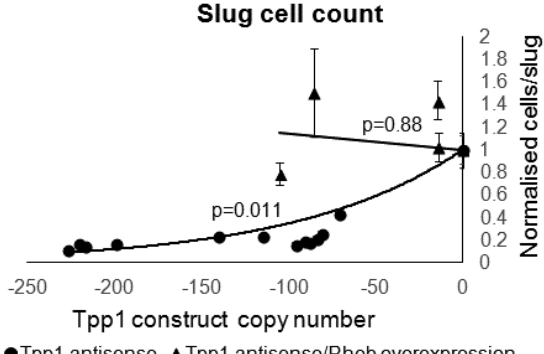
Figure 10. Overexpression of Rheb rescued the decrease in slug sizes caused by Tpp1 knockdown. The average number of cells per slug for each strain was plotted against the Tpp1 antisense inhibition construct copy number. At least 30 slugs were counted for each strain and the error bars represent standard error. The regression was significant at the indicated p values (t test). The line for the Tpp1 antisense strains was fitted by the least squares method to an exponential equation. The line for the Tpp1 antisense / Rheb overexpression transformants was fitted by were fitted by the least squares method to a straight line.